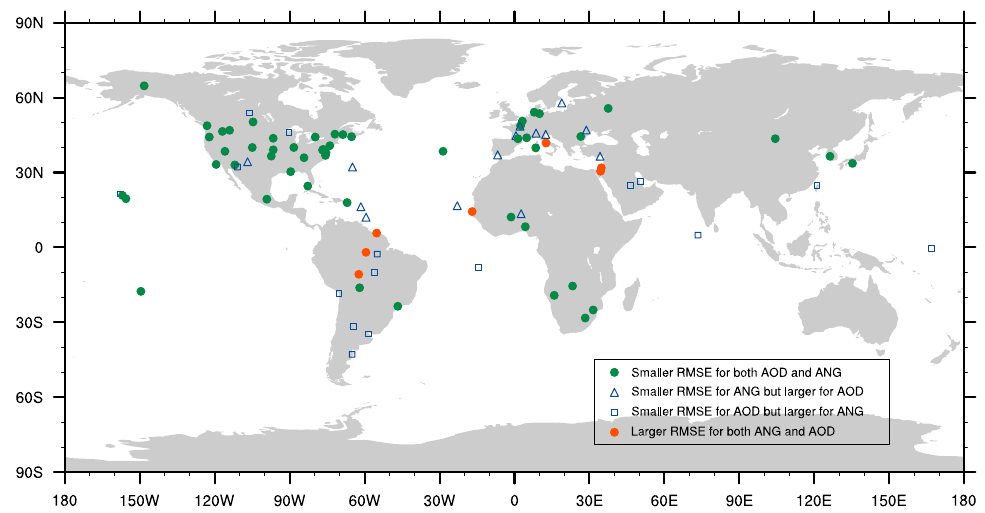
Fig. 20. Map showing the AERONET sites at which the daily mean aerosol optical depth (AOD) and ˚Angstr¨om parameter (ANG) of the year 2000 are used for the comparison in Fig. 21. At each site the root mean square error (RMSE, of daily mean AOD or ANG) against measurements is computed for both the HAM1 and HAM2 simulations. Green dots indicate improved results in HAM2 (reduced RMSE) for both AOD and ANG; Orange dots indicate degraded results for both parameters; empty triangles and rectangles mark the locations where mixed results are obtained. AOD is calculated/retrieved at the mid-visible wavelength 0.55µm. The AERONET ˚Angstr¨om parameter is